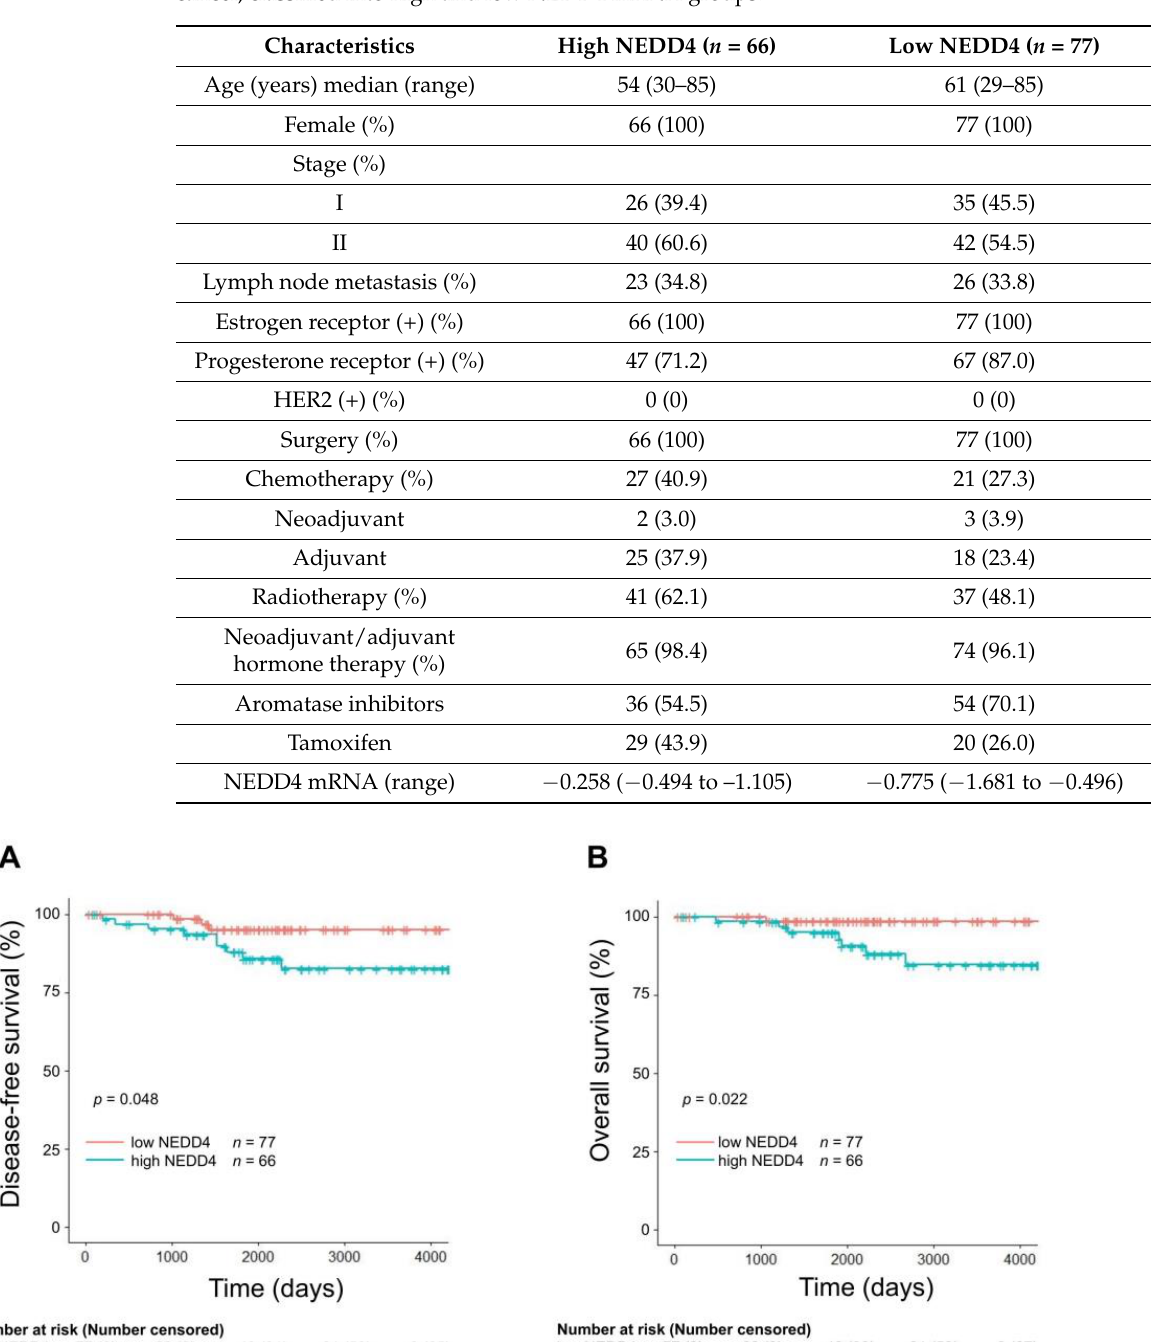
Table 1. Clinicopathological characteristics of the patients with HR-positive HER2-negative breast cancer, classified into high and low NEDD4 mRNA groups.